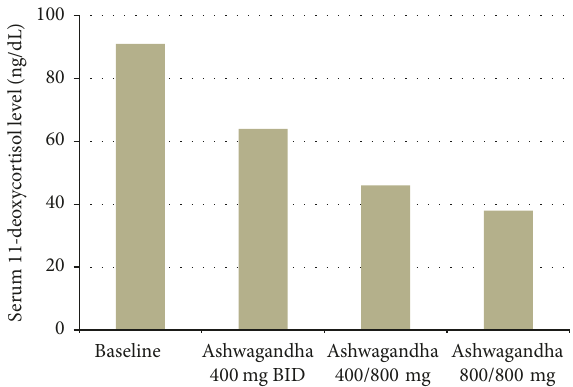
Figure 1: Effect of Ashwagandha root on serum 11-deoxycortisol